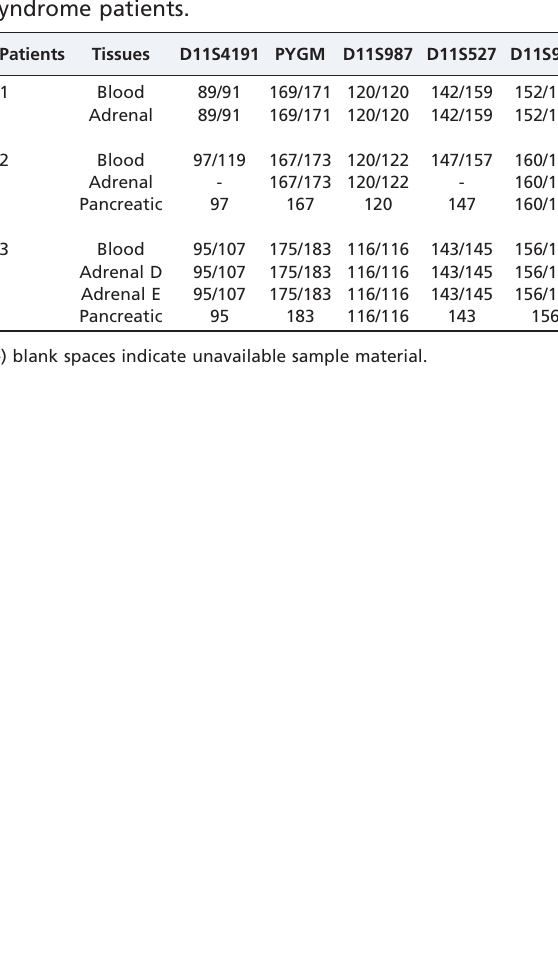
Supplementary Table 2 - MEN 1 mutations identified in different tissues of MEN1 syndrome patients.